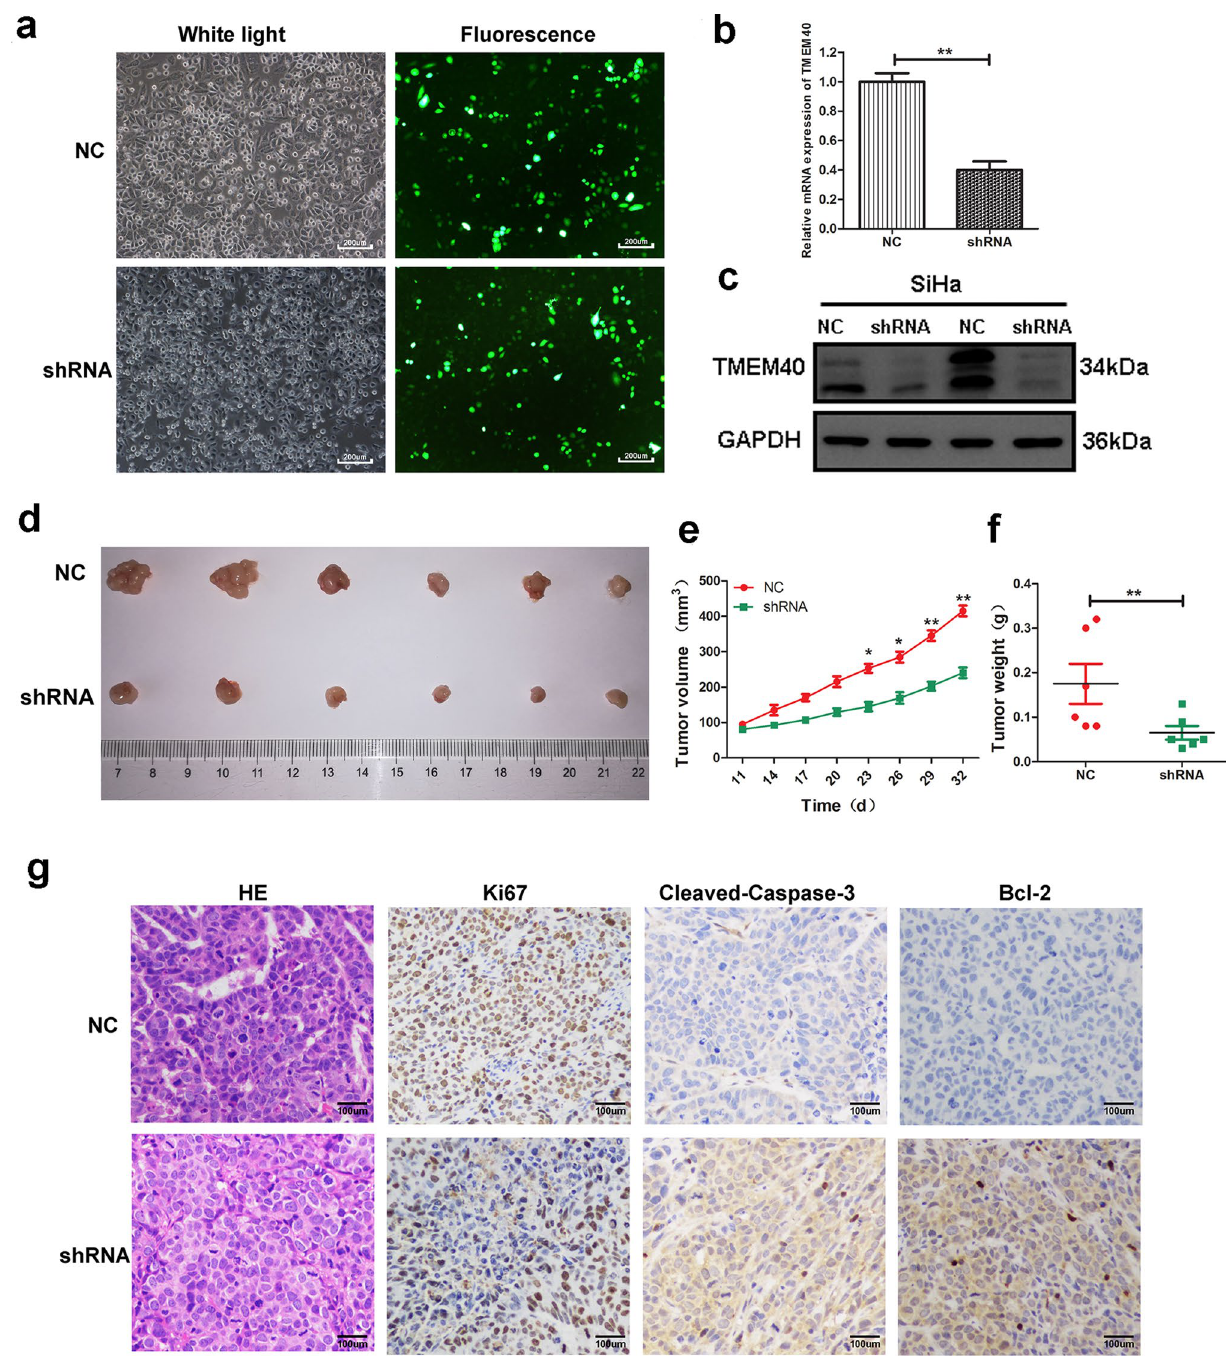
Fig. 6 TMEM40 promotes CC cell tumorigenesis in vivo. a, The expression of green fluorescent protein after 48 h of TMEM40 shRNA transfec- tion in SiHa cells (× 100). b and c , Transfection efficiency was tested by western blot and qRT-PCR. d , Tumor samples in nude mice induced by SiHa cells transfected with NC or TMEM40 shRNA at 32 days after injection. e , Tumor volumes were calculated every 3 days beginning 11 days after injection. f, Tumor weights in nude mice at 32 days after injection. g , Images of CC samples by H&E staining, or IHC staining for Ki67, Cleaved-Caspase-3 and Bcl-2. (× 200). * P < 0.05, ** P <